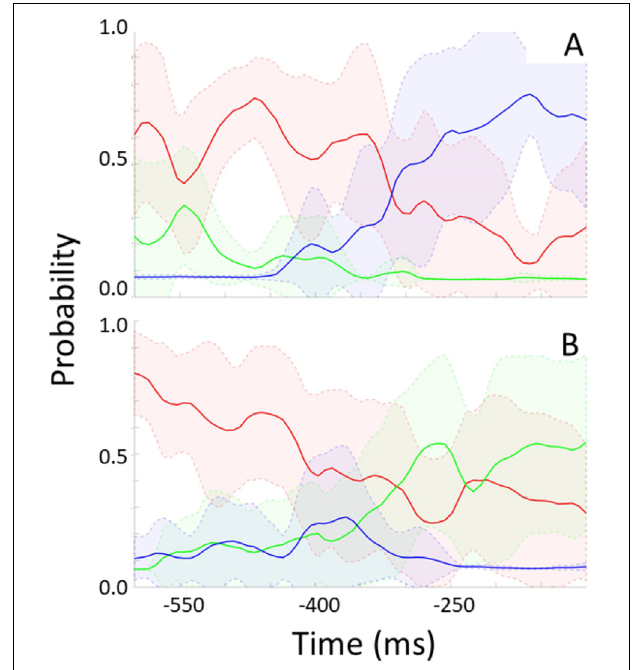
FIGURE 6 | Modeled probability for no rotation (red), rightward rotation (blue), and leftward rotation (green) over time preceding rightward rotation (A) and leftward rotation (B) . Probabilities are averaged across participants and data intervals [representing a total of 58 rightward rotations in (A) , and a total of 63 leftward rotations in (B) ]. Shaded areas represent standard deviations.